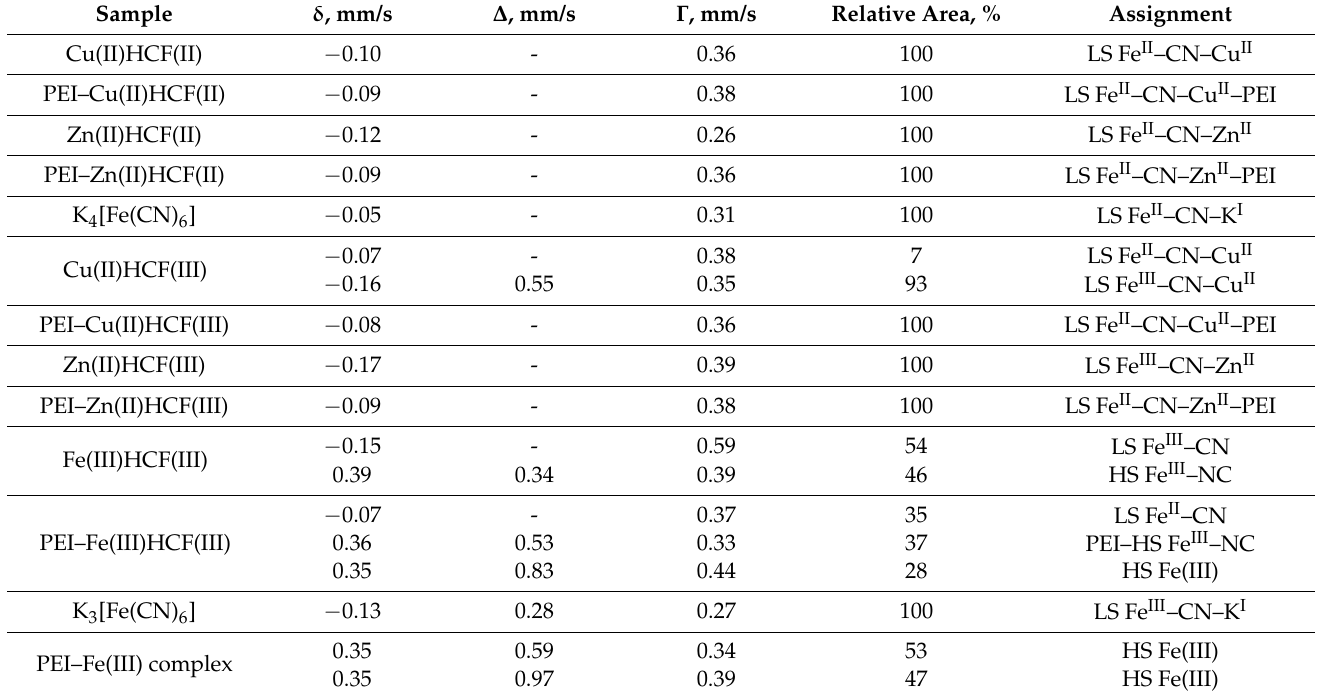
Table 2. Mossbauer parameters for crystalline HCFs and PEI–HCF hybrids, T = 298 K